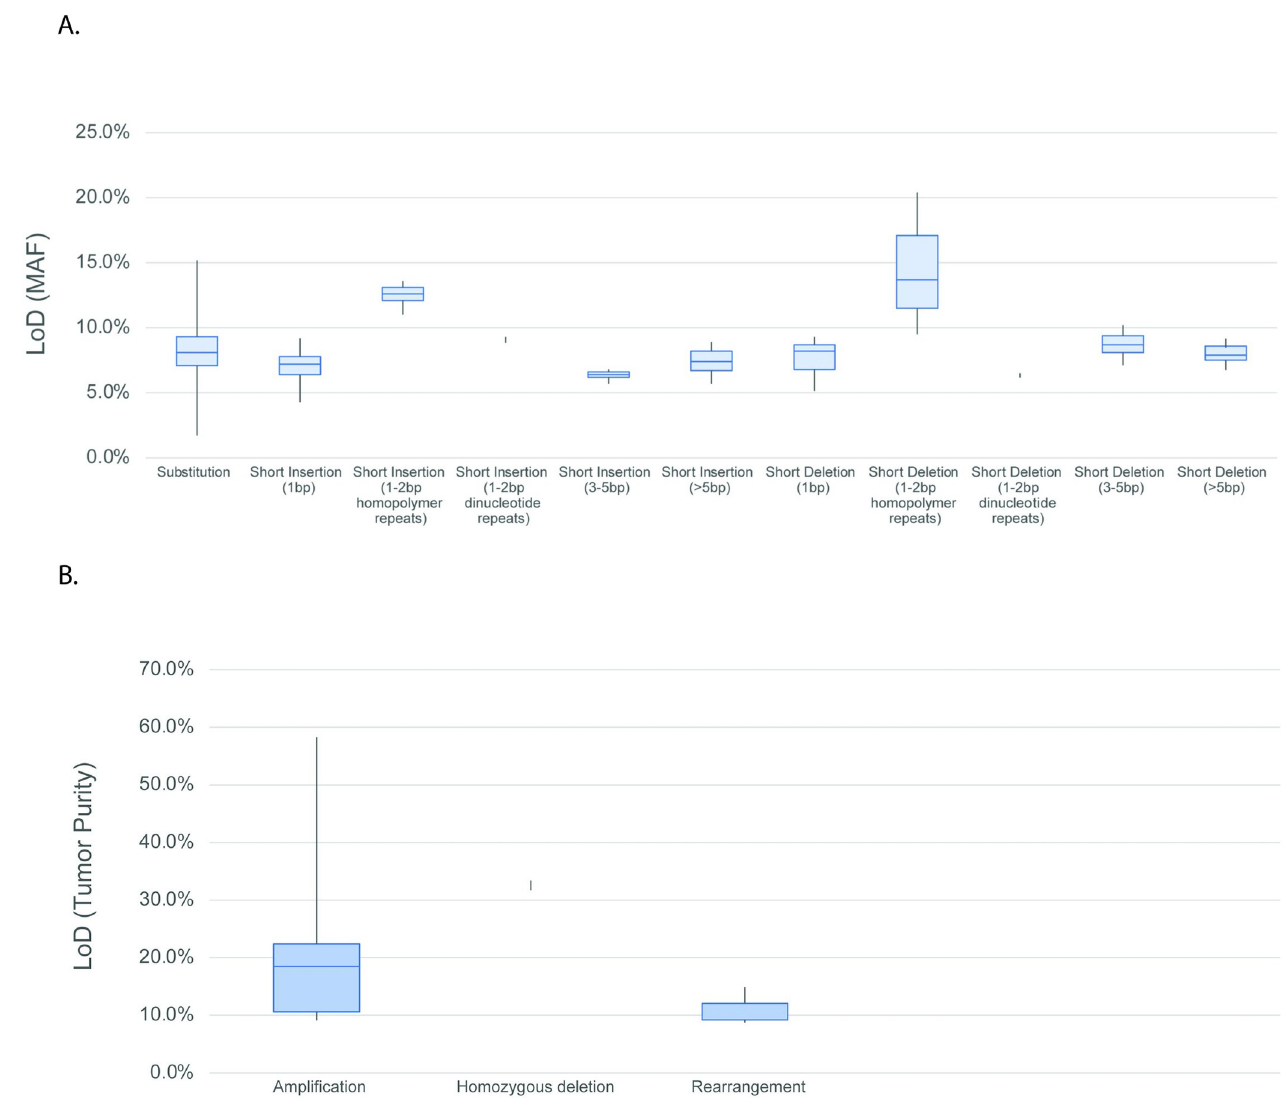
Fig 2. LoD ranges for (A) SVs and (B) amplifications and rearrangements a LoD calculations for the platform variants were based on the hit rate approach for variants with less than three levels with hit rate between 10% and 90% and probit approach for variants with at least three levels with hit rate between 10% and 90%. LoD from the hit rate approach is defined as the lowest level with 95% hit rate (worst-case scenario). b Data includes an alteration in the TERT promoter, 124C > T (LoD of 7.9%). TERT is the only promoter region interrogated and is highly enriched for repetitive context of poly-Gs, not present in coding regions. c Alterations classified as “known” are defined as those that are listed in COSMIC. d Alterations classified as “other” include truncating events in tumor suppressor genes (splice, frameshift, and nonsense) as well as variants that appear in hot-spot locations but do not have a specific COSMIC association or are considered VUS due to lack of reported evidence and conclusive change in function. e Sensitivity calculations for the platform variants were based on the hit rate approach for variants with less than three levels with hit rate between 10% and 90% and probit approach for variants with at least three levels with hit rate between 10% and 90%. LoD from the hit rate approach is defined as the lowest level with 95% hit rate (worst-case scenario). f Max represents VUS alteration at calling threshold. bp = base pair; CN = copy number; Mb = megabase; MSI = microsatellite instability; mut = mutation; TMB = tumor mutation burden; VUS = variants of unknown